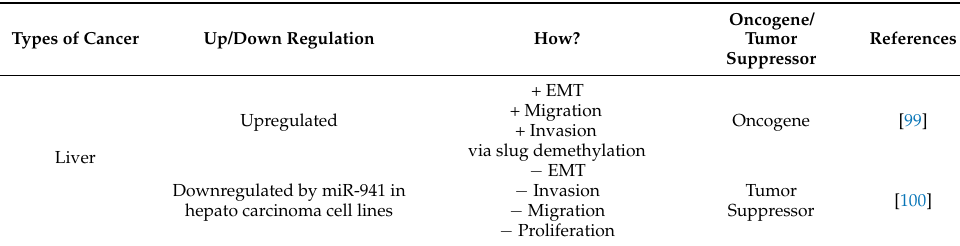
Table 1. Jumonji domain-containing protein 3 demethylase regulation in liver, ovarian, and gastric cancers a